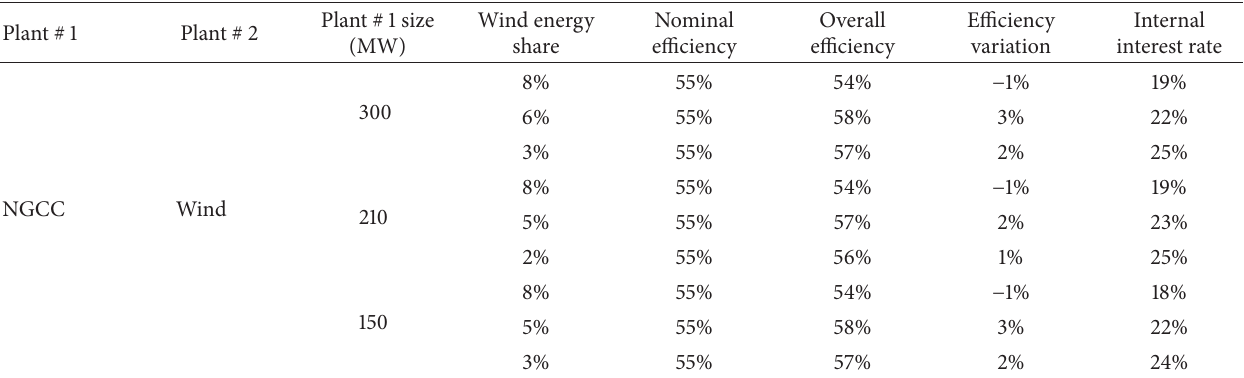
Table 6: Evaluation model for NGCC + wind